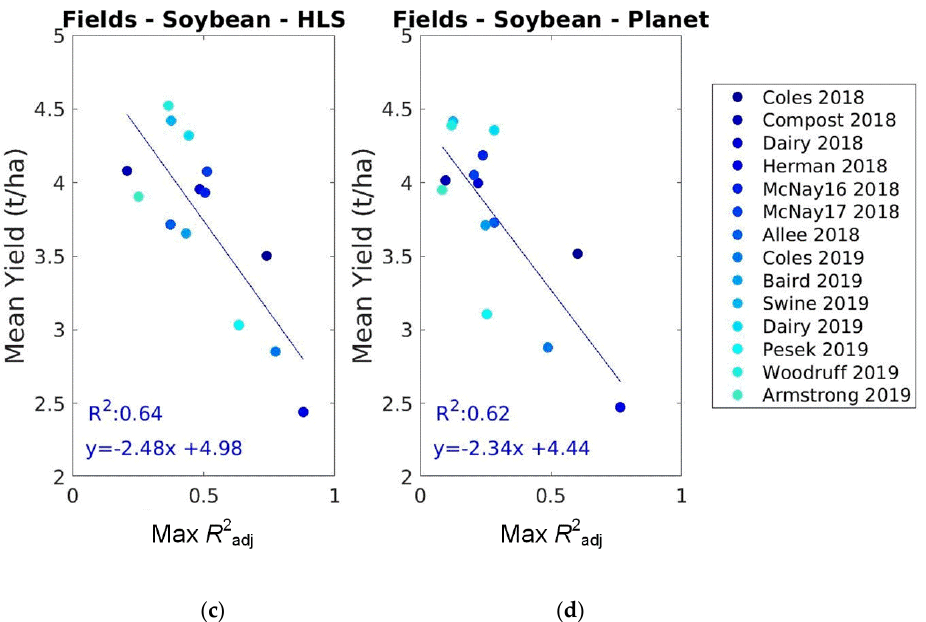
Figure 12. Dependence of the coefficient of determination R 2 for the best HLS- and Planet-based models on field yield: ( a )–( b ) for corn and ( c )–( d ) for soybean.